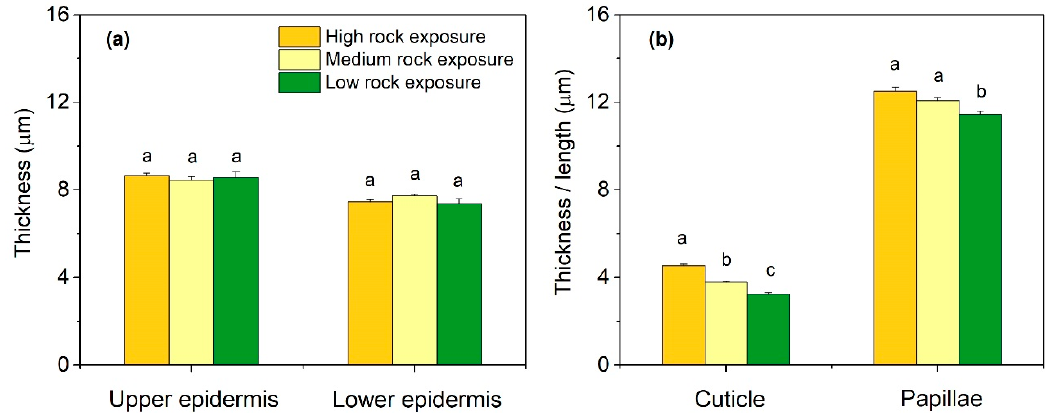
Figure 2. Leaf epidermal traits of Phyllostachys glauca from three habitats (high rock exposure, me- dium rock exposure, and low rock exposure) in the limestone mountain. ( a ), the thickness of upper epidermis and lower epidermis; ( b ), the thickness of cuticle and the length of papillae. Values are means ± S.E. ( n = 100). Lowercase letters that differ within an anatomical trait indicate significant ( p < 0.05) differences among different habitats.